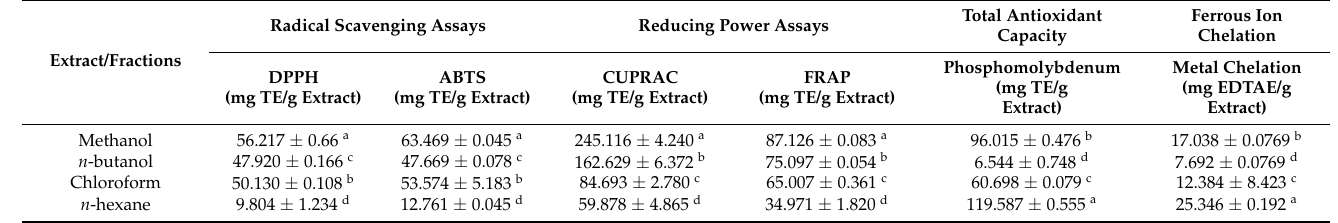
Table 5. Antioxidant results by different methods of S. glutinosus whole plant extract/fractions. Radical Scavenging Assays Reducing Power Assays Extract/Fractions